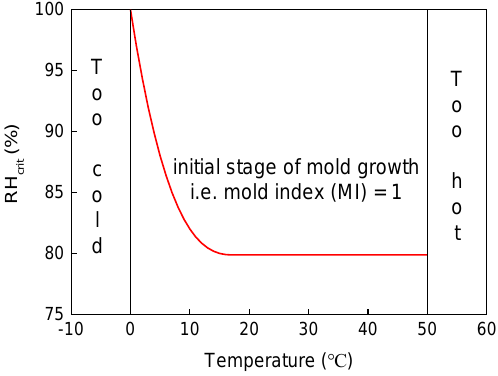
Figure 1. The critical relative humidity (RH) for mold growth on a wooden material [9].